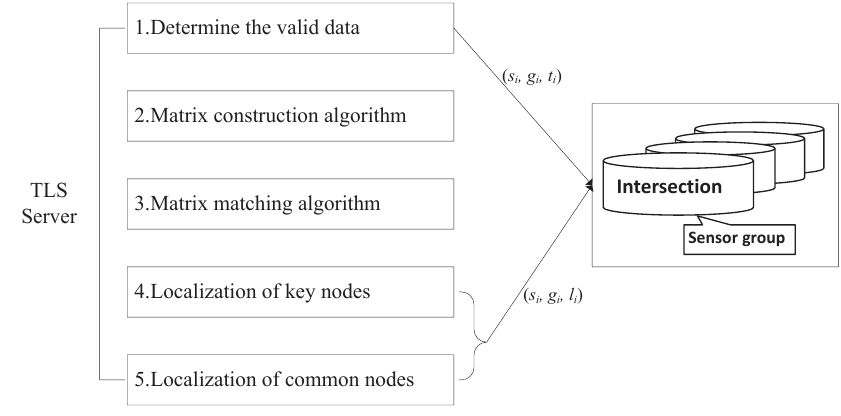
Figure 2. TLS system